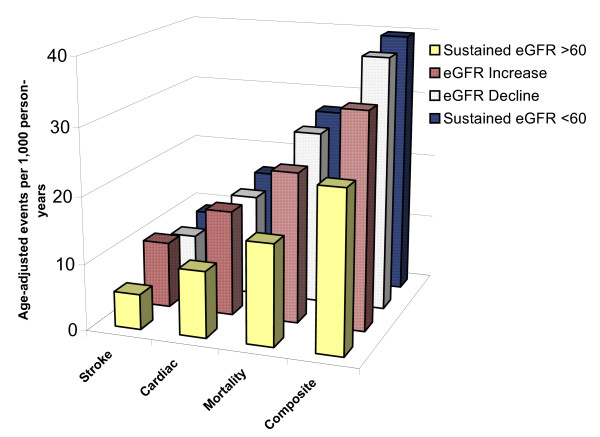
Age-adjusted event rates per 1,000 person-years, calculated using the SAS® PROC GENMOD with the Poisson distribution option and adjusting for varying follow-up time of individual participants.